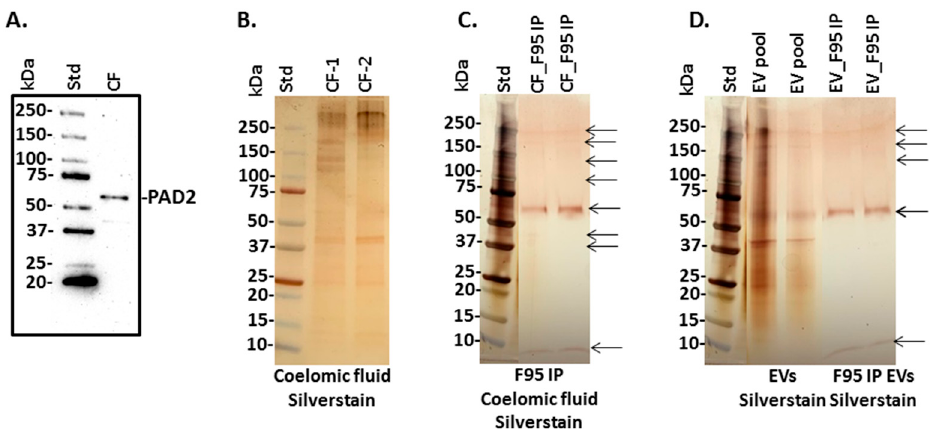
Figure 3. Peptidylarginine deiminase (PAD)-like protein detection and deiminated proteins in sea urchin coelomic fluid. ( A ) Using the human PAD2-specific antibody, a strong positive band was detected in coelomic fluid (CF). ( B , C ) Coelomic fluid (CF) was silver-stained for total protein ( B ); the F95-enriched proteins from coelomic fluid (CF) are shown in ( C )—protein bands for F95-enriched proteins are highlighted with arrows. ( D ) Showing total proteins as detected by silver staining in EVs isolated from sea urchin coelomic fluid (a pool of 3 samples was used for the EV enriched fraction) and citrullinated/deiminated proteins were isolated from the EVs using F95 enrichment (EV_F95 IP); arrows point at main F95-enriched protein bands. The molecular weight standard (Std) is shown on the left hand side of each blot/gel and indicated in kilodaltons